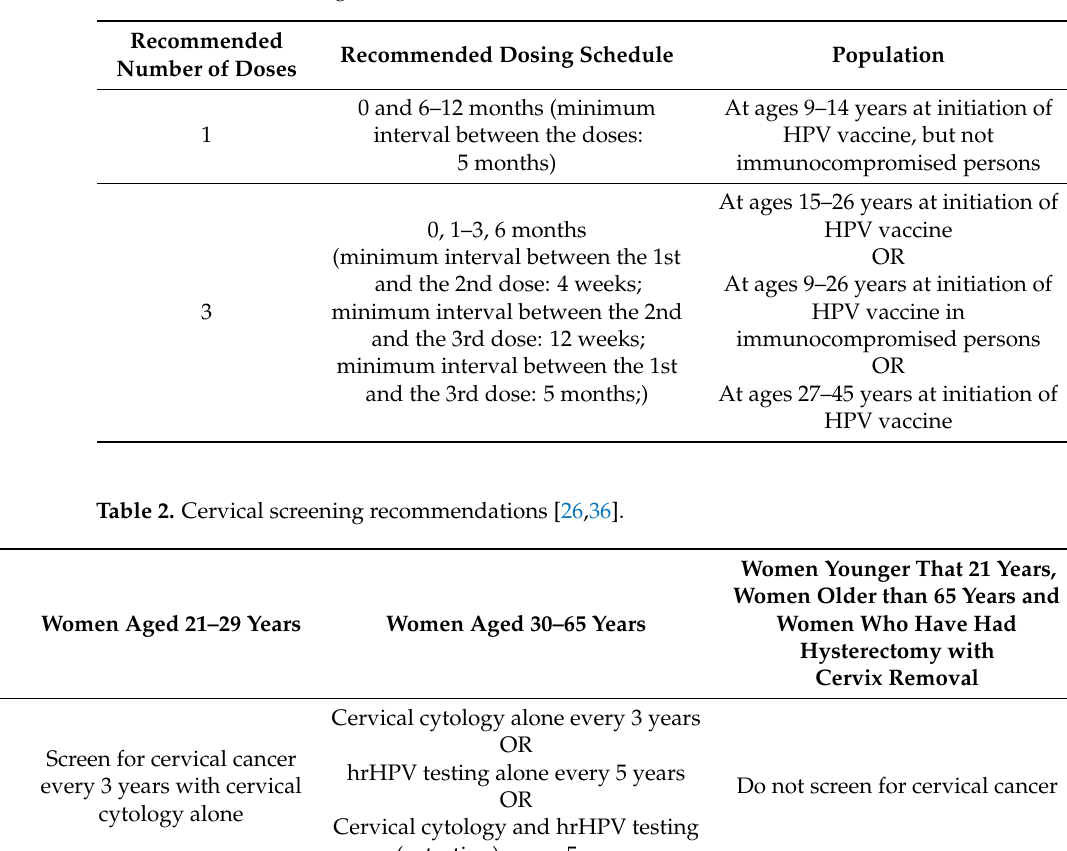
Table 1. HPV vaccine regiments (for ninevalent vaccine) [28].